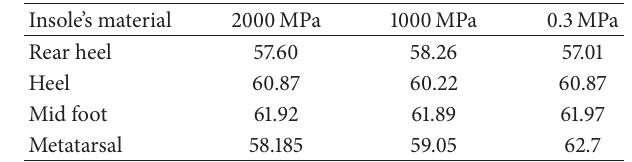
Table 2: Maximum stress in heel, mid foot, and metatarsal regions for two different materials and custom-molded insole. The thickness of insoles is 2